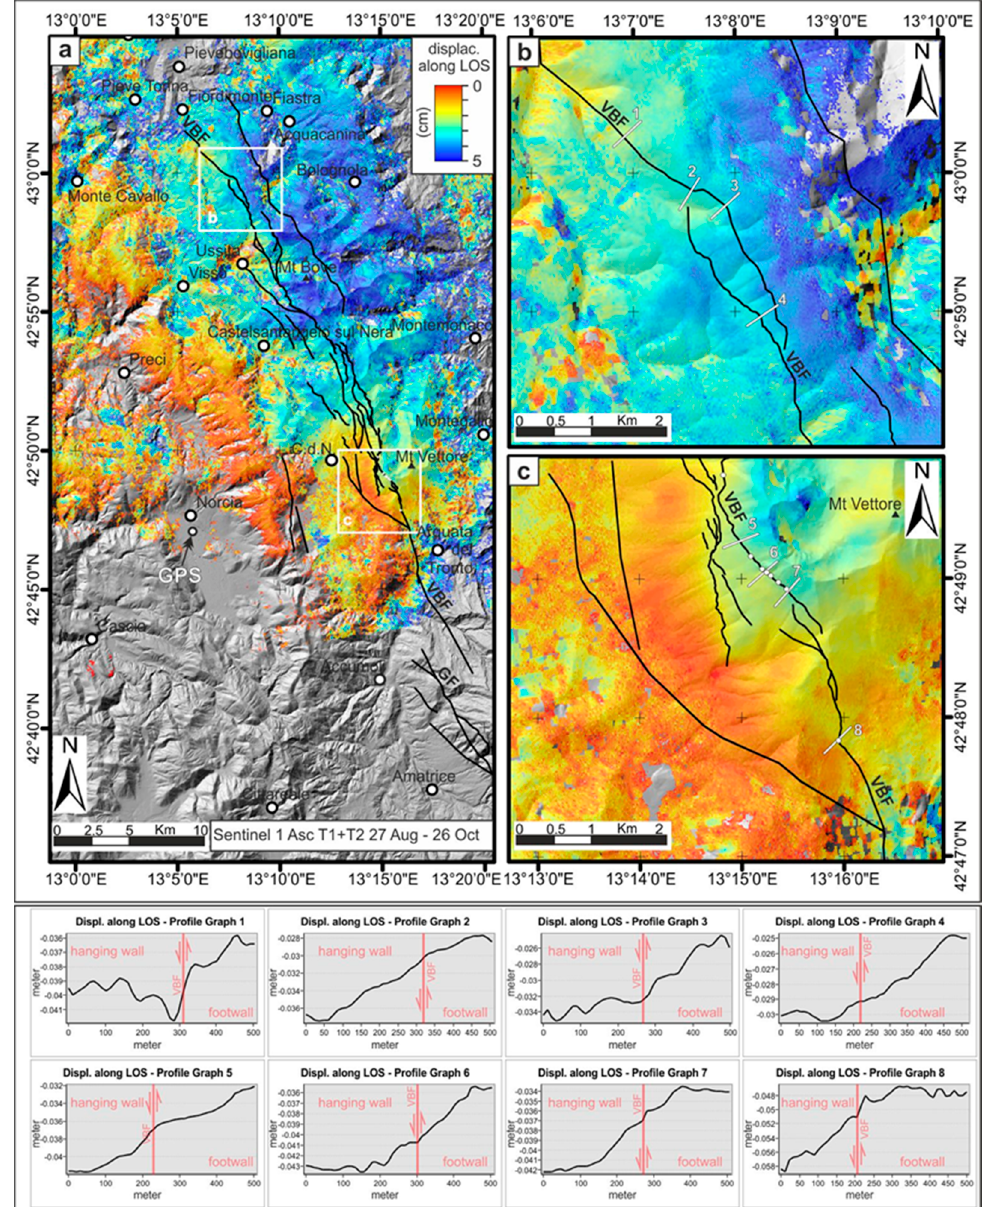
Figure 5. Displacement field obtained for the study area during the T1+T2 period along the ascending orbit. ( a ) Relative displacement field computed over high-coherence areas. The traces of the Vettore-Bove (VBF) and northern Gorzano (GF) fault are shown as black lines. ( b ) and ( c ): high-coherence sample areas selected to test the reliability of the observed displacement compared to the IGD detected in the interferograms of Figure 3 in the northern ( b ) and southern ( c ) sector of the VBF hanging wall and used to determine the Length of Deforming Ground (LDG). A coherence map of the area is provided in Figure S4a–c. The profiles (traces in b and c ) show the displacements observed across the VBF whose intersection and sense of slip are indicated by the red vertical line.